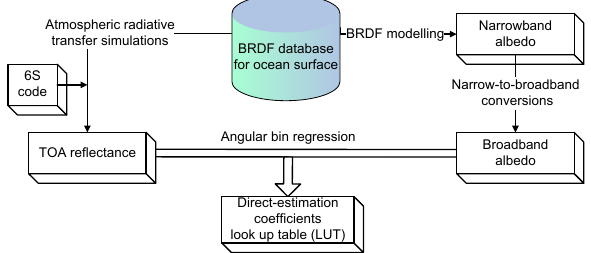
Fig.2 Direct-estimation algorithm for mapping ocean surface broadband albedo